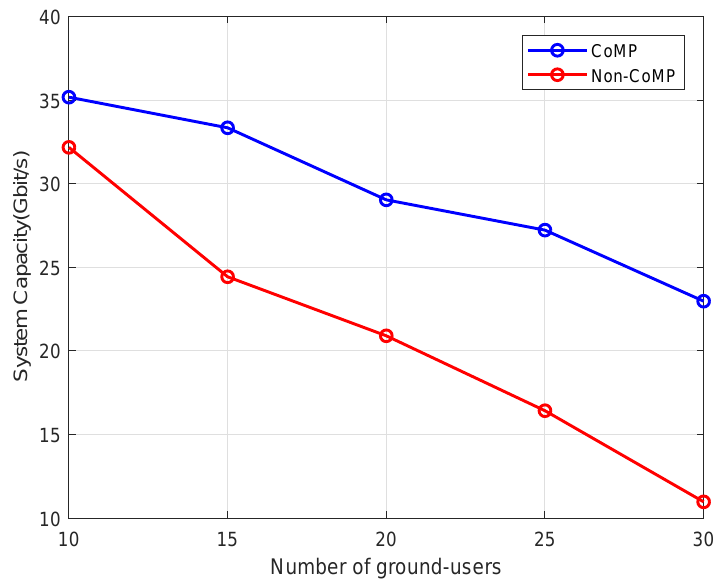
Figure 7. Sum-rate comparison of CoMP and Non-CoMP under different number of users